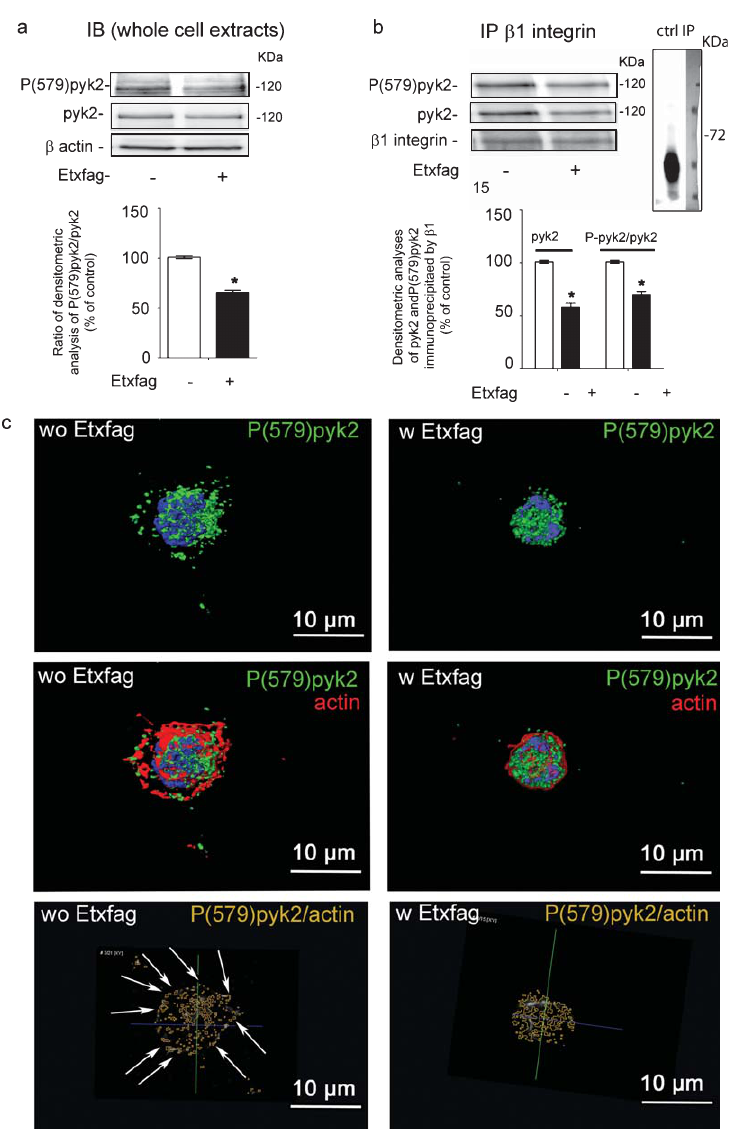
Fig. 6. Etxfag prevents pyk2 phosphorylation and association with (cid:1) 1 integrin. a ) Whole cell lysates prepared from L1210 cells treated or not with 1 × 10 − 7 M Etxfag during 24h were subjected to immunoblotting with anti-phosphorylated-Y579 -pyk2 and pyk2. A representative blot of three independent experiments was shown. Graph represents the densitometric analysis of the ratio P(579)pyk2/pyk2 in control ( (cid:1) ) and treated ( (cid:2) ) cells.* P <0.05. b ) Cell lysates prepared from L1210 cells treated or not with 1 × 10 − 7 M etxfag during 24h were immunoprecipitated with anti- (cid:1) 1antibody and immunoblotted with anti-phosphorylated-Y579-pyk2 and pyk2. Non specific IgGs were used as negative controls of immunoprecipitation(windows).Arepresentativeblotofthreeindependentexperimentswasshown.Graphrepresentsthedensitometricanalysis of the ratio P(579)pyk2/pyk2 in control ( (cid:1) ) and treated ( (cid:2) ) cells. * P <0.05. c ) L1210 cells treated or not with 1 × 10 − 7 M etxfag for 24h were seeded to FN/V for 2h. Cells were fixed with paraformaldehyde 4% and permeabilized with 0.1% Triton X-100. Cells were labelled with anti-phosphorylated-Y579-pyk2 and then with a secondary antibody linked to Alexafluor 488 (green). Cells were also incubated with Alexafluor 568-conjugated phalloidin (red) to visualize F-actin distribution. Blue color represents nuclear staining with DAPI. Surfacic reconstructions were realized from L1210 cells treated with (right row) or without etxfag (left row). Upper panels represent P(579)pyk2 labelling, middle panels represent P(579)pyk2+F-actin labelling and bottom panels represent colocalization between P(579)pyk2 and F-actin (gold). A representative image of three independent experiments is